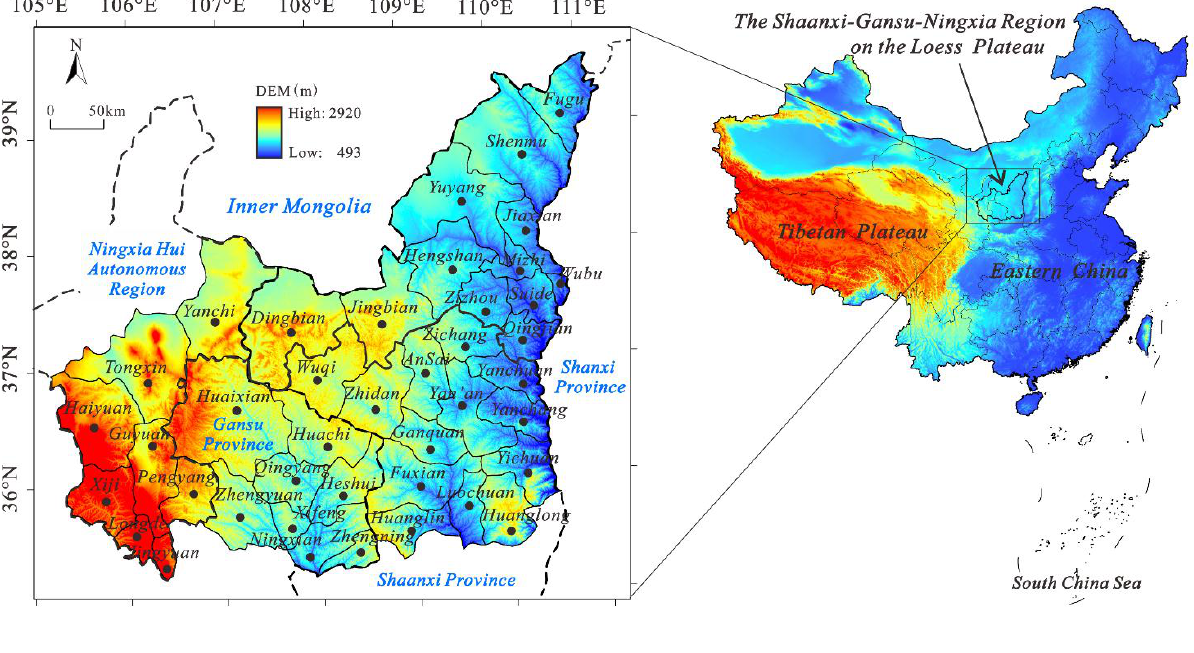
Figure 1. The study